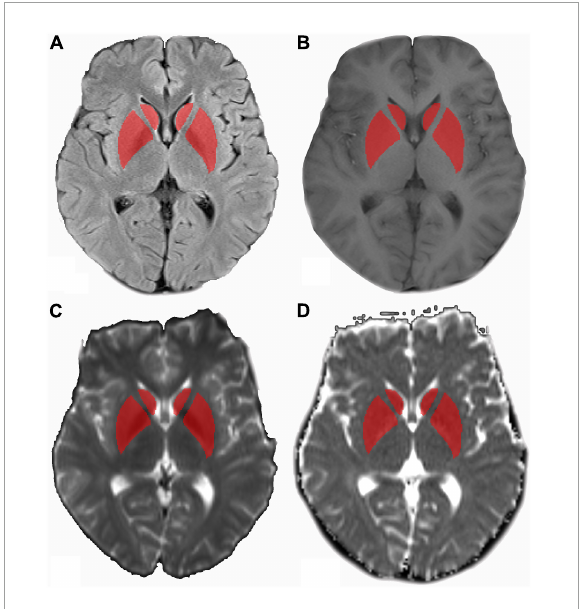
FIGURE2 MR images in a 25-year-old patient with pre-eclampsia (PE). (A) Axial T2WI marked with ROI drawn on bilateral basal ganglia